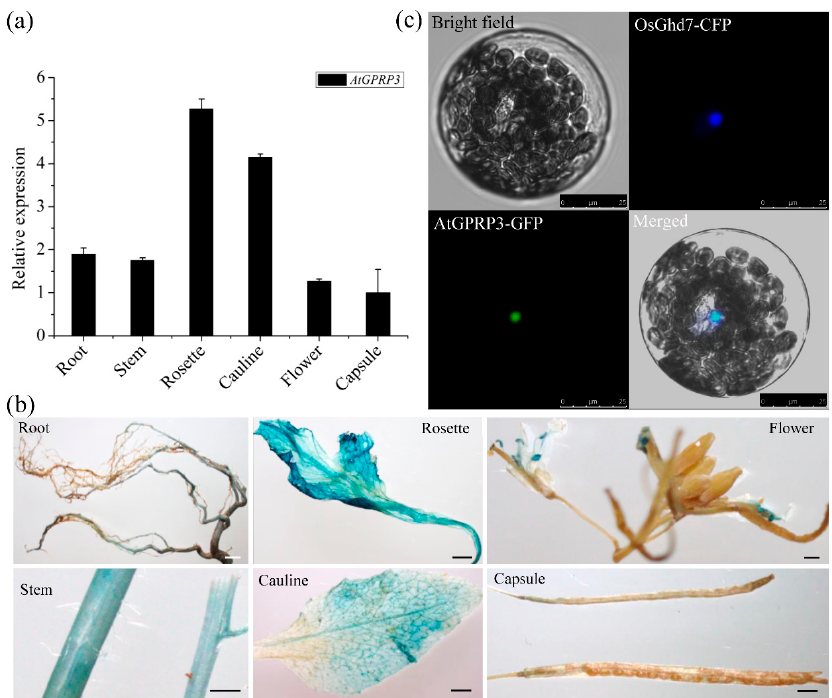
Figure 2. The expression and subcellular localization of AtGPRP3. ( a ) Tissue-specific expression of AtGPRP3. Total RNAs were extracted from different tissues including roots, stems, rosette, cauline, flowers, and capsules of Col-0 plants grown under normal conditions. Relative expression was calculated with Cq values from qRT-PCR experiments. Data are mean ± SE for three replicates. ( b ) Tissue-specific distribution of AtGPRP3 transcripts. β -glucuronidase (GUS) staining was conducted with various tissues in transgenic plants carrying the pAtGPRP3::GUS reporter. Bar = 2 mm. ( c ) Subcellular localization of AtGPRP3. AtGPRP3-GFP and OsGhd7-CFP (a nuclear marker) were constitutively expressed in Arabidopsis protoplasts. The green fluorescent protein (GFP) and cyan fluorescence protein (CFP) fluorescence images were taken from the same cell and merged. Bar = 25 μ m.